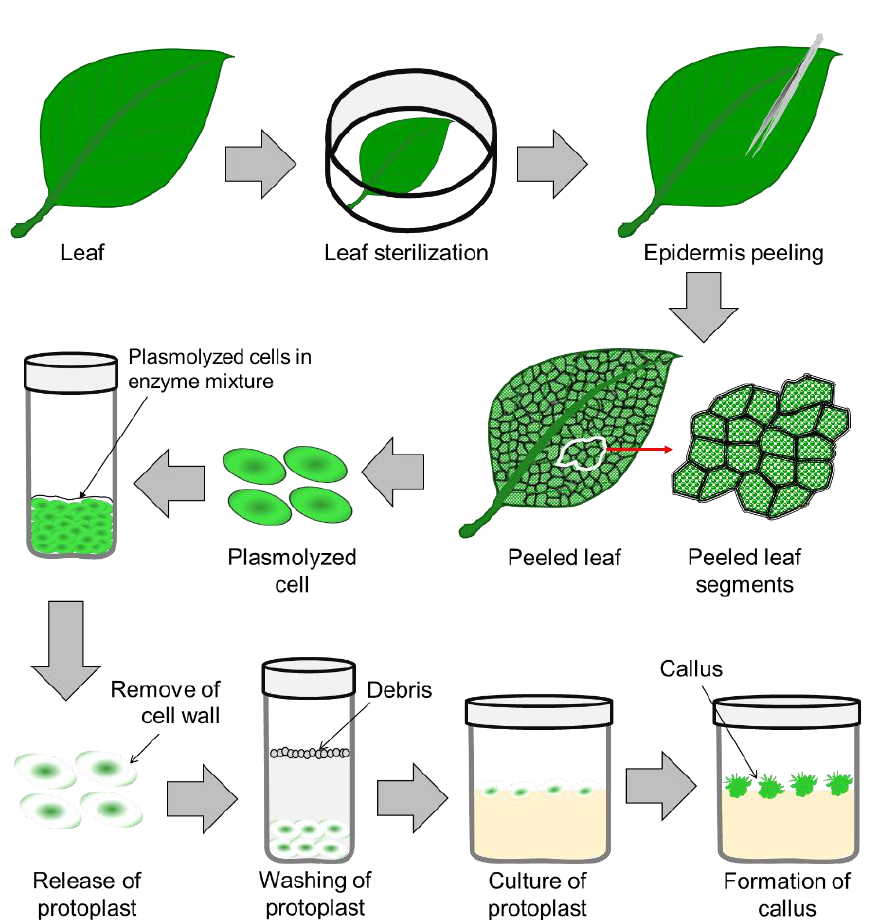
Figure 2. A detailed scheme of protoplast isolation and establishment of an in vitro protoplast